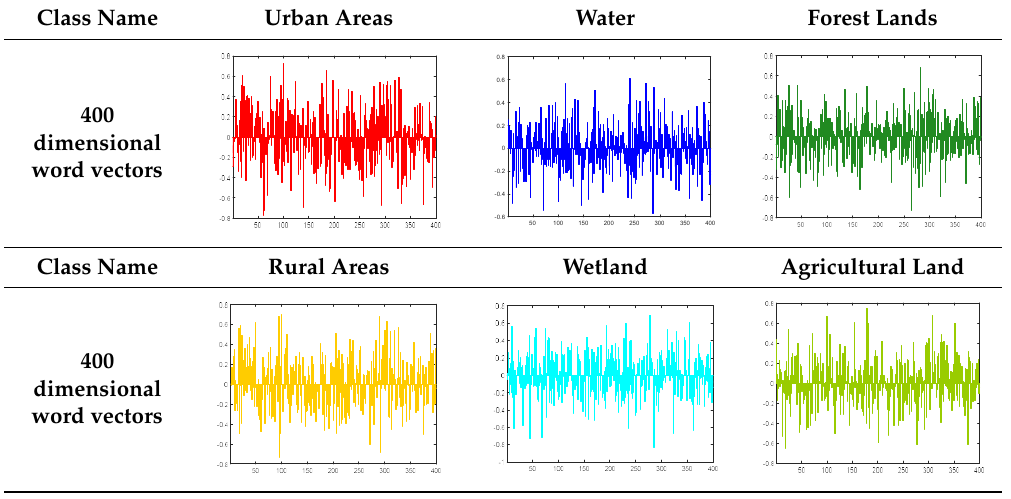
Table 2. The examples of the land cover class and corresponding SUN/selected SUN attribute vectors.